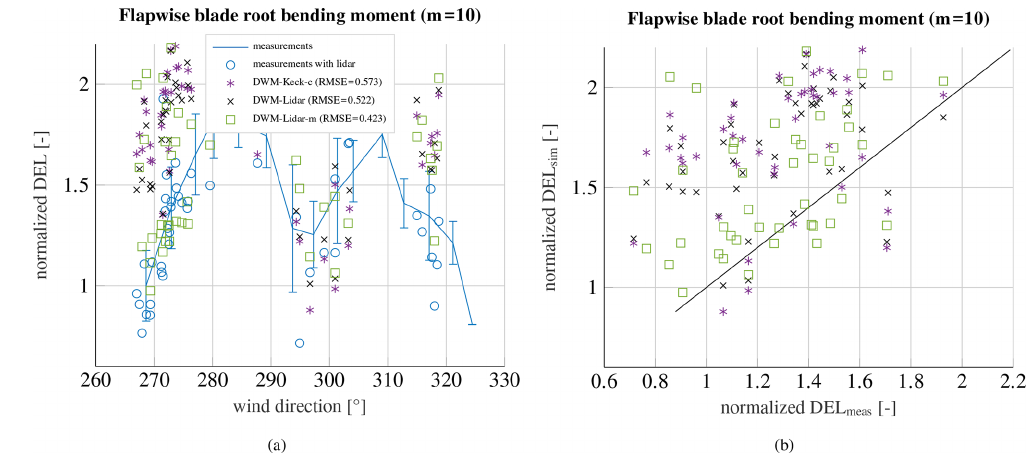
Figure 15. Measured and simulated flapwise blade root bending moment over the wind direction (a) and simulated loads over measured loads (b) at an ambient wind speed of 8ms − 1 and an ambient turbulence intensity of 10%, when WTG 2 is exposed to the wake of WTG 1.